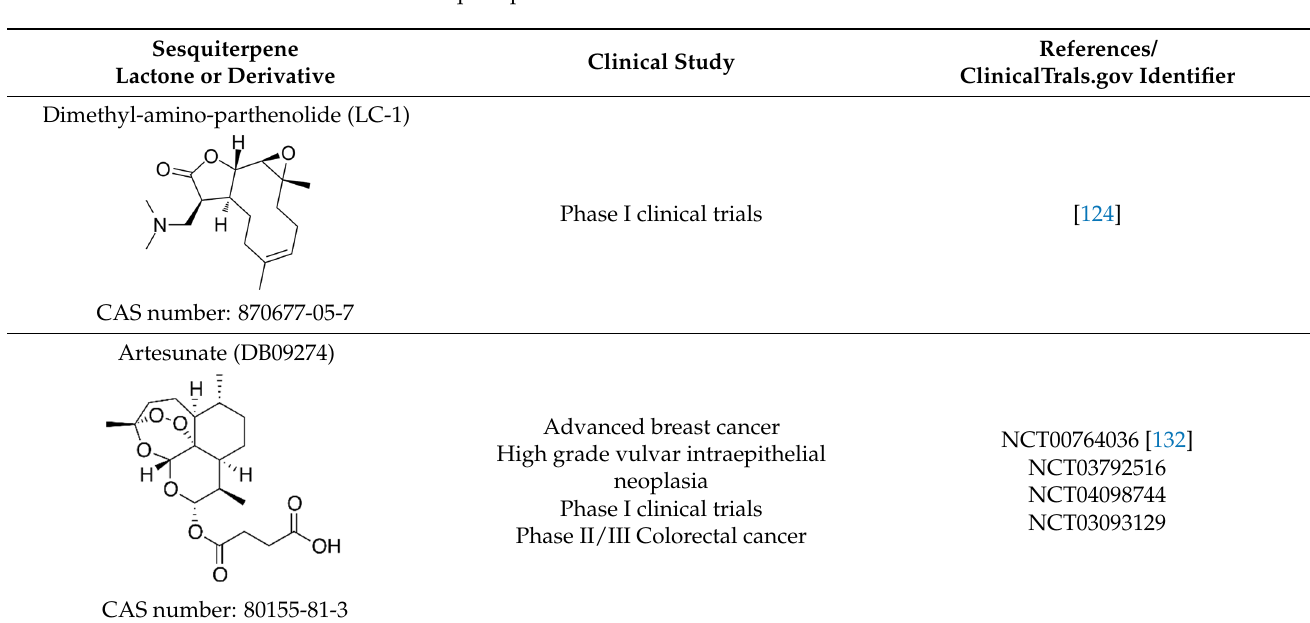
Table 3. Sesquiterpene lactones and their derivatives with clinical relevance.